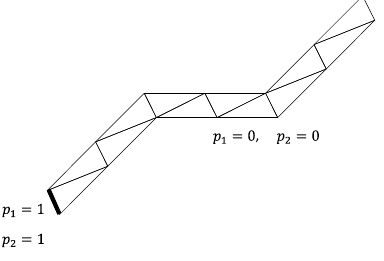
Figure 7. Domain problem for the first numerical experiment, with boundary conditions, and coarsest grid consisting of 12 triangles. Homogeneous Dirichlet boundary conditions are prescribed in the whole boundary except at the left bottom part, where both unknowns are fixed to be equal to one. The domain is composed of three parallelograms with a